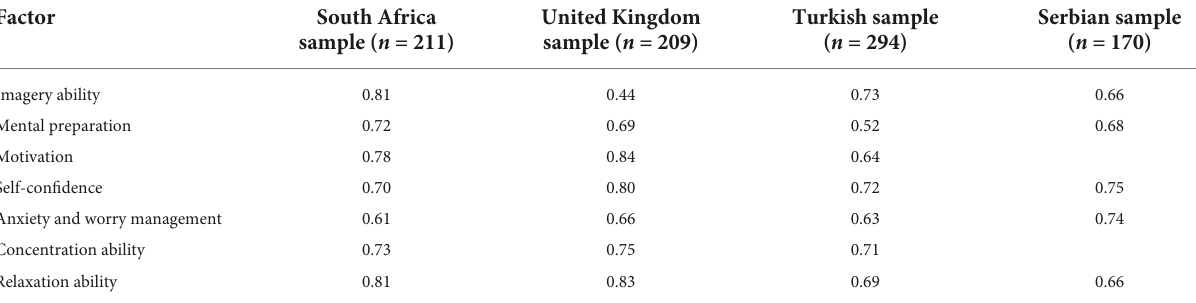
TABLE 4 Result of reliability analysis (Cronbach alfa) and comparative review of obtained results in South Africa and United Kingdom (Edwards et al., 2014), Turkey (Miçoo˘gullari et al., 2021), and Serbia. Factor